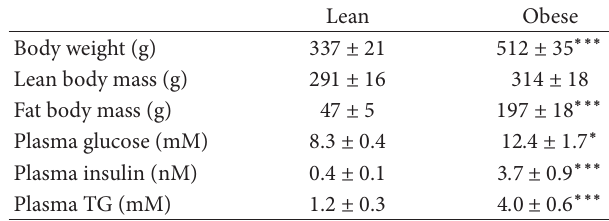
Table 1: Body weights and plasma factors in lean and obese Zucker rats, Series 1.